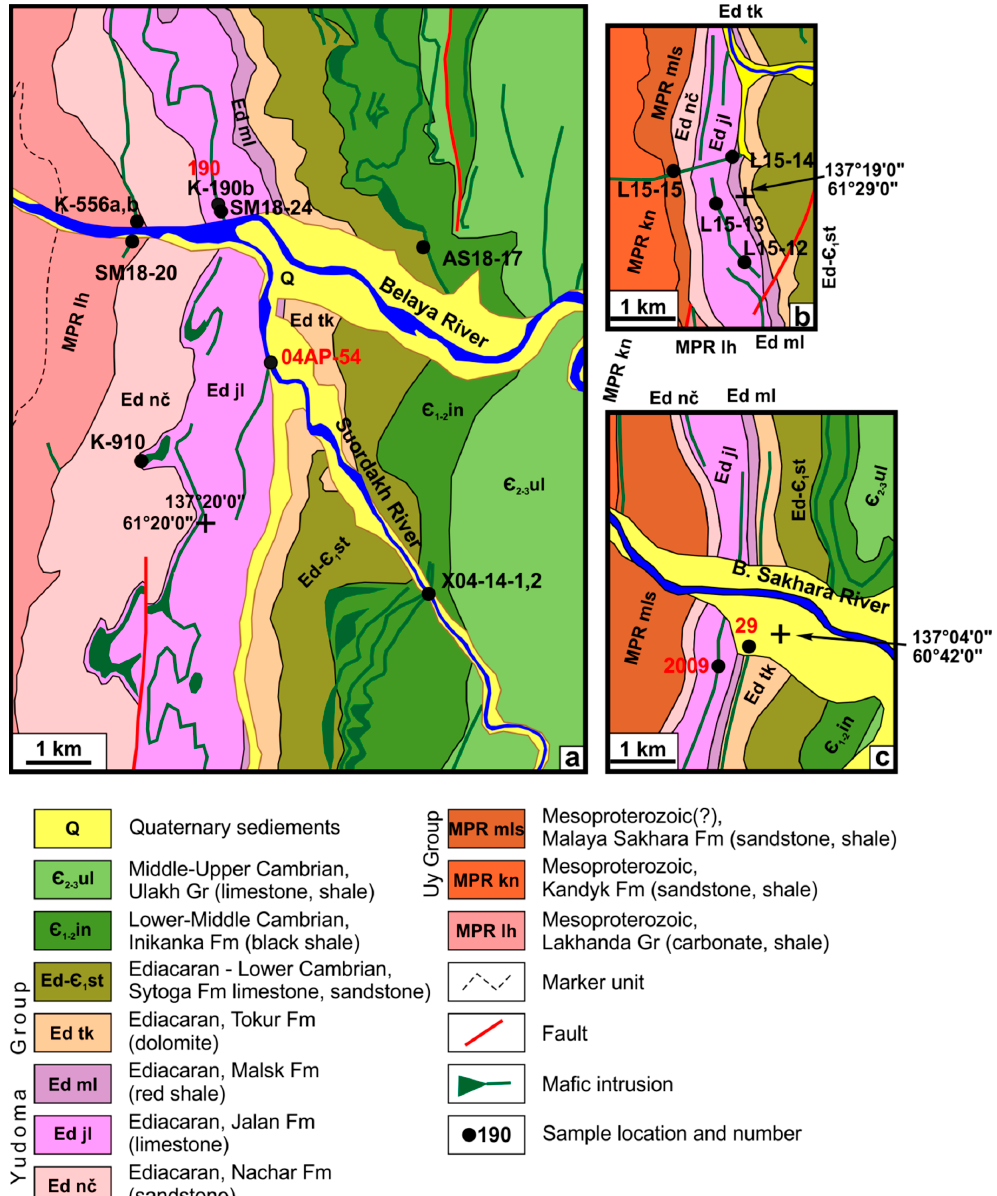
Figure 2. Geological setting of the sampled intrusions of this study (geology after [32–34], modified). ( a ) Central part of the east limb of the Gornostakh Anticline, Belaya River area. ( b ) Northern part of the east limb of the Gornostakh Anticline. ( c ) B. Sakhara River area, see location of Figure 2a–c in Figure 1. Samples L15-14 and L15-15 are from an E-W-trending dyke, all other in Figure 2 are from sills. Samples with red numbers are from [10], samples with black numbers are from this study. Locations of samples X04-20 and X04-29 are shown in Figure 1, sample L15-13 is from the same dyke as X04-29 (N-S-trending dyke).